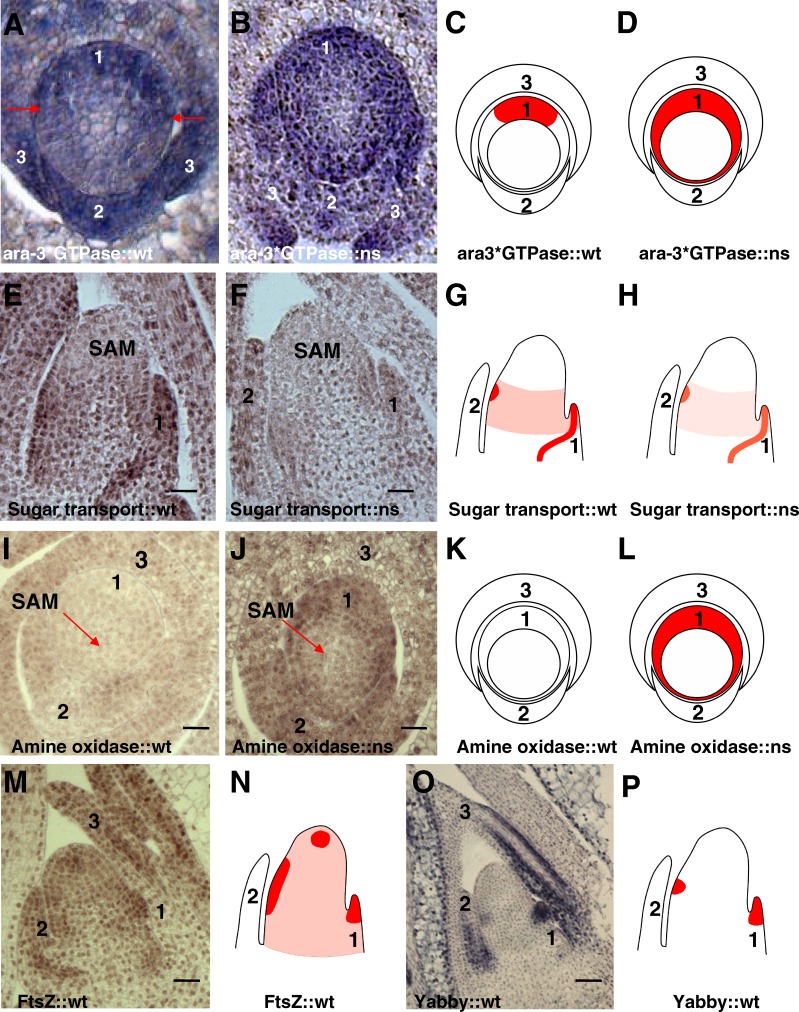
In Situ Hybridization Reveals Domain-Specific Expression of Differentially Expressed Maize Genes in Nonmutant and ns1-R Mutant Shoot Apices, Part IIDrawings of SAM expression patterns are modeled in (C and D), (G and H), (K and L), and (N and P). Differentially expressed maize genes are shown in nonmutant (wild type: [A], [E], [I], [M], and [O]) and ns1-R mutant (ns: [B], [F], and [J]) shoot apices. No expression in leaf primordia is portrayed in drawings, since transcripts accumulating in leaves were not LM sampled or reflected in microarray data. Probes were made from maize ESTs: DN232668 (A and B), DY400928 (E and F), AI820200 (I and J), CB381550 (M), and CD650947 (O). Predicted functions are abbreviated as: ara GTPase, GTP-BINDING PROTEIN ARA-3; sugar trans, SUGAR TRANSPORTER PROTEIN; amine oxidase, AMINE OXIDASE1; FtsZ, CELL DIVISION FTSZ PROTEIN; and Yabby, YABBY-RELATED PROTEIN. Numbers denote leaf primordia. Analyses of expression patterns are provided in the text.